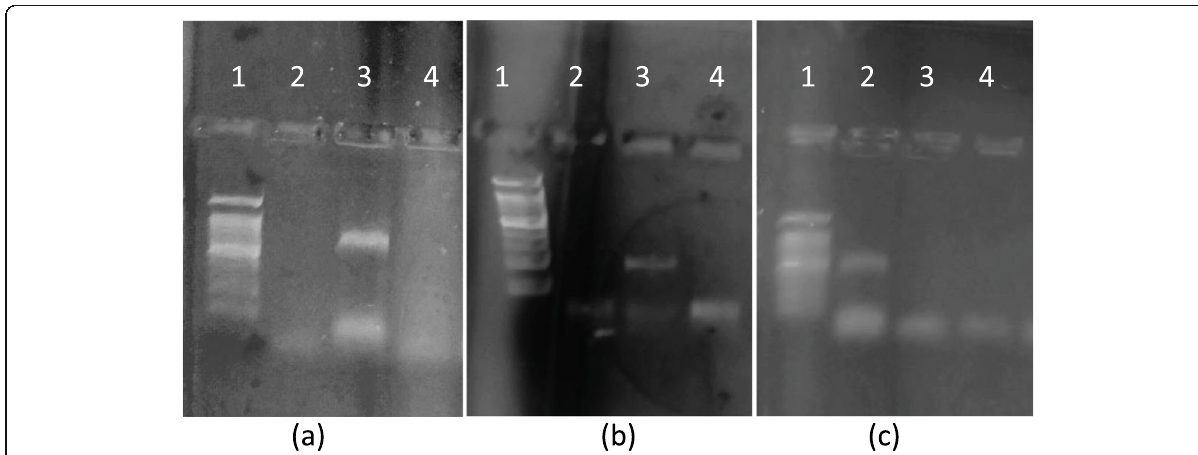
Fig. 6 Specificity of primers. a 16s r-DNA: lane 1 — 100 bp ladder, lane 2 — 16s rDNA with C. albicans culture, lane 3 — 16s rDNA with S. aureus culture, lane 4 — negative control. b β -galactocidase: lane 1 — 100 bp ladder, lane 2 — β -gal with S. typhi, lane 3 — β -gal with E. coli., lane 4 — negative control. c ITS: lane 1 — 100 bp ladder, lane 2 — ITS with C. albicans., lane 3 — ITS with E. coli, lane 4 — negative